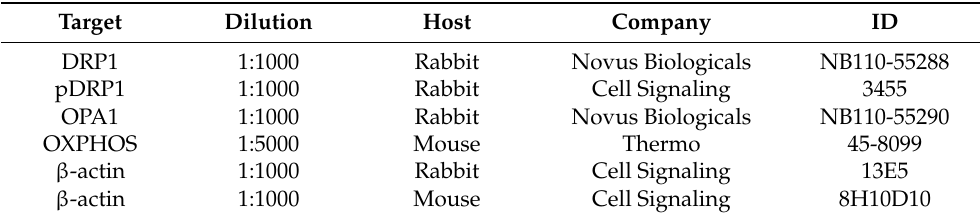
Table 2. Primary antibody information and